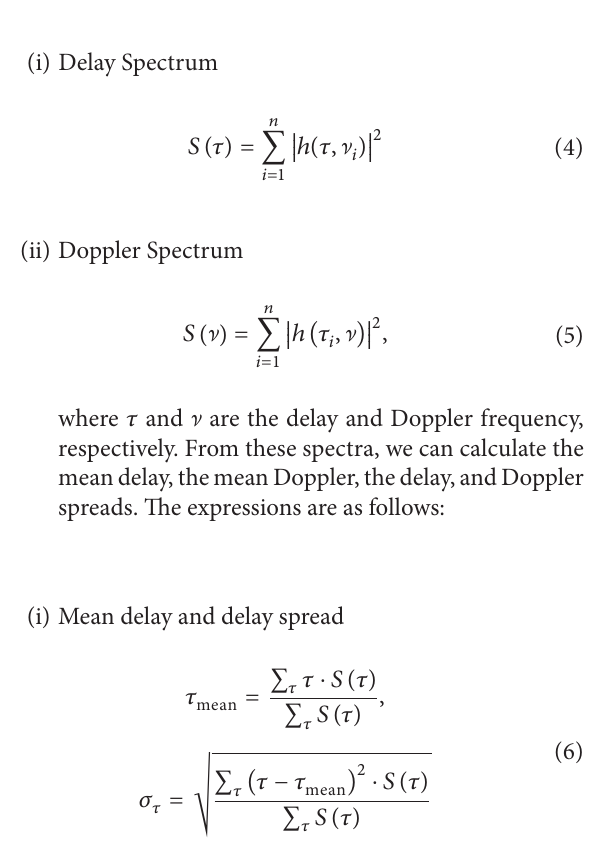
of dihedral, 𝑁 𝑟 and 𝑁 𝑑 , respectively, the number of con- sidered reflections and diffractions, the number of potential paths 𝑆 between the transmitter and the receiver can be evaluated